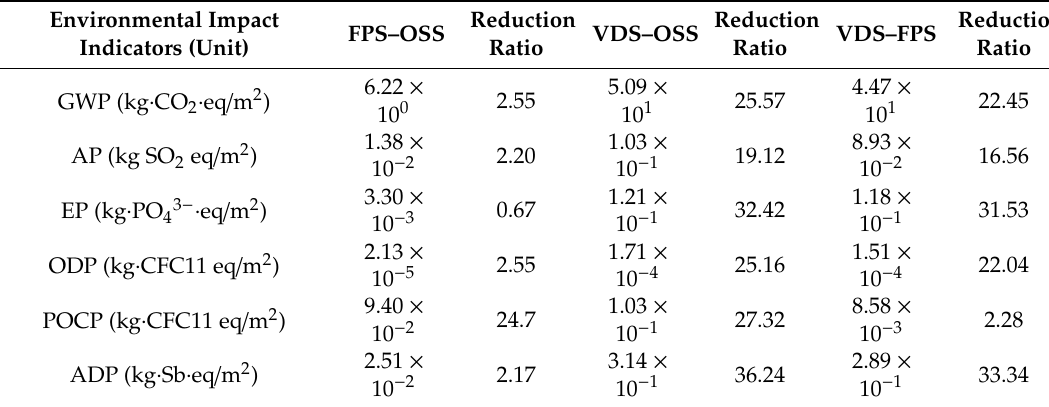
Table 5. Reduction in environmental impact